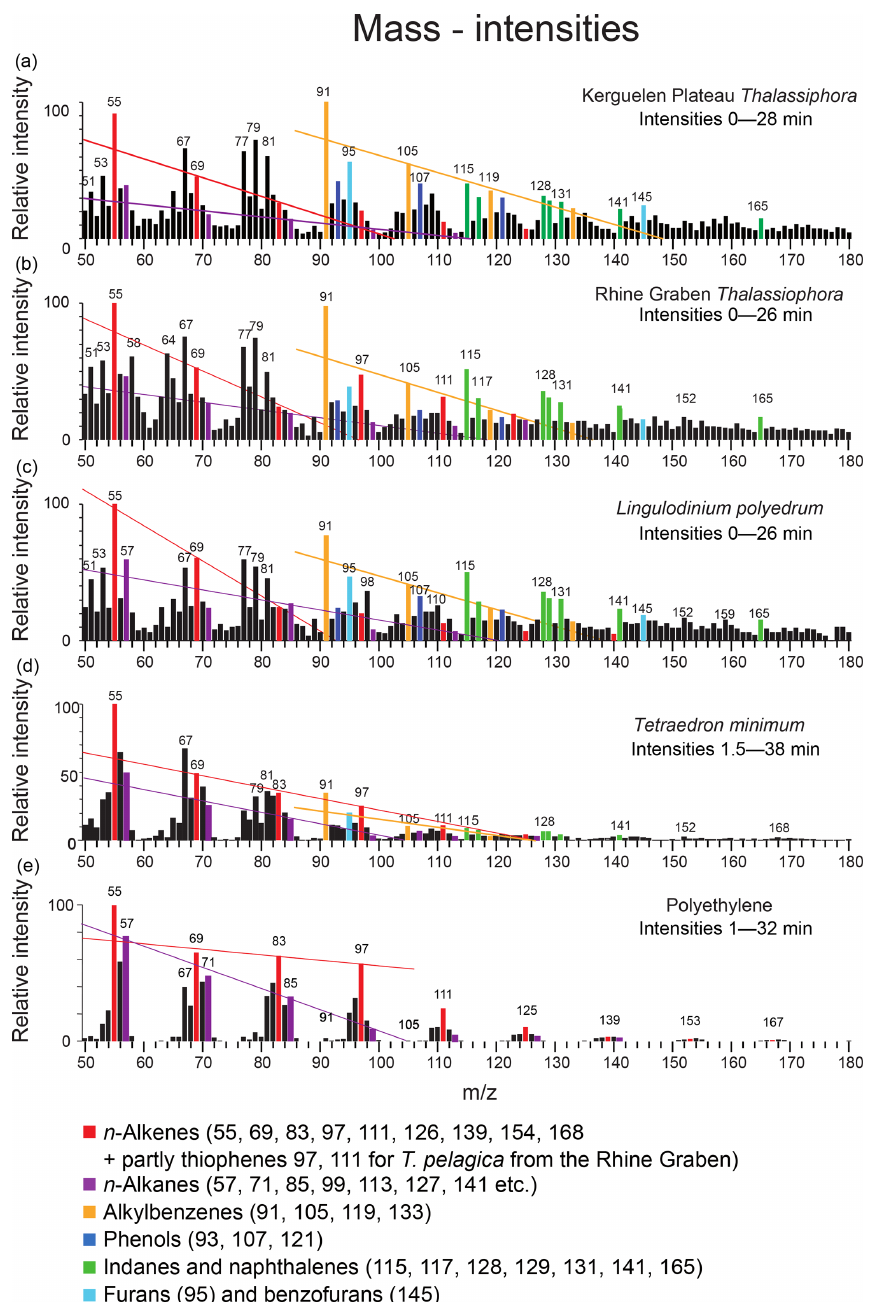
Figure 6. Mass intensity plots of the total chromatograms of (a) Thalassiphora pelagica from the Kerguelen Plateau, (b) Thalassiphora pelagica from the Rhine Graben (Versteegh et al., 2007), (c) recent Lingulodinium polyedrum (Versteegh et al., 2012), (d) Tetraedron minimum and (e) polyethene. The lines connect masses indicative for n -alkenes ( m/z 69, 83, 97), n -alkanes ( m/z 57, 71, 85, 99) and alkylbenzenes ( m/z 105, 119), respectively. Note that the total ion current of polyethene is dominated by series of ions meeting the criteria C n H 2n − 1 and C n H 2n + 1 , reflecting the highly aliphatic nature of the macromolecule. Note the relatively high aromatic contribution for T. pelagica (orange bars; m/z 91, 105, 115, 117, 128, 129, 131) in comparison to the “aliphatic-derived” fragments of alkanes and alkenes and the high relative contribution of m/z 97 and 111 for T. pelagica from the Rhine Graben as compared to m/z 69 and 83, which is attributed to the presence of